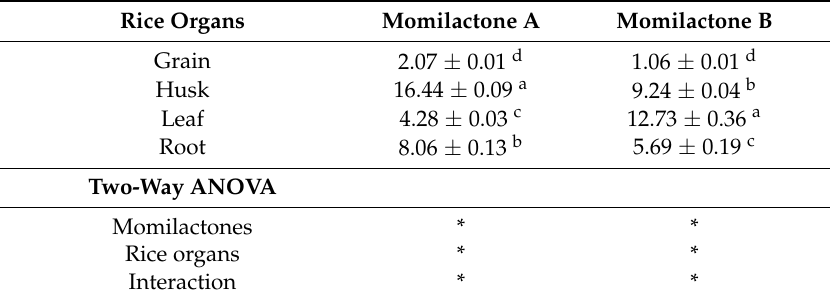
Table 2. Momilactone contents in rice grain, husk, leaf, and root ( µ g/g DW). Rice Organs